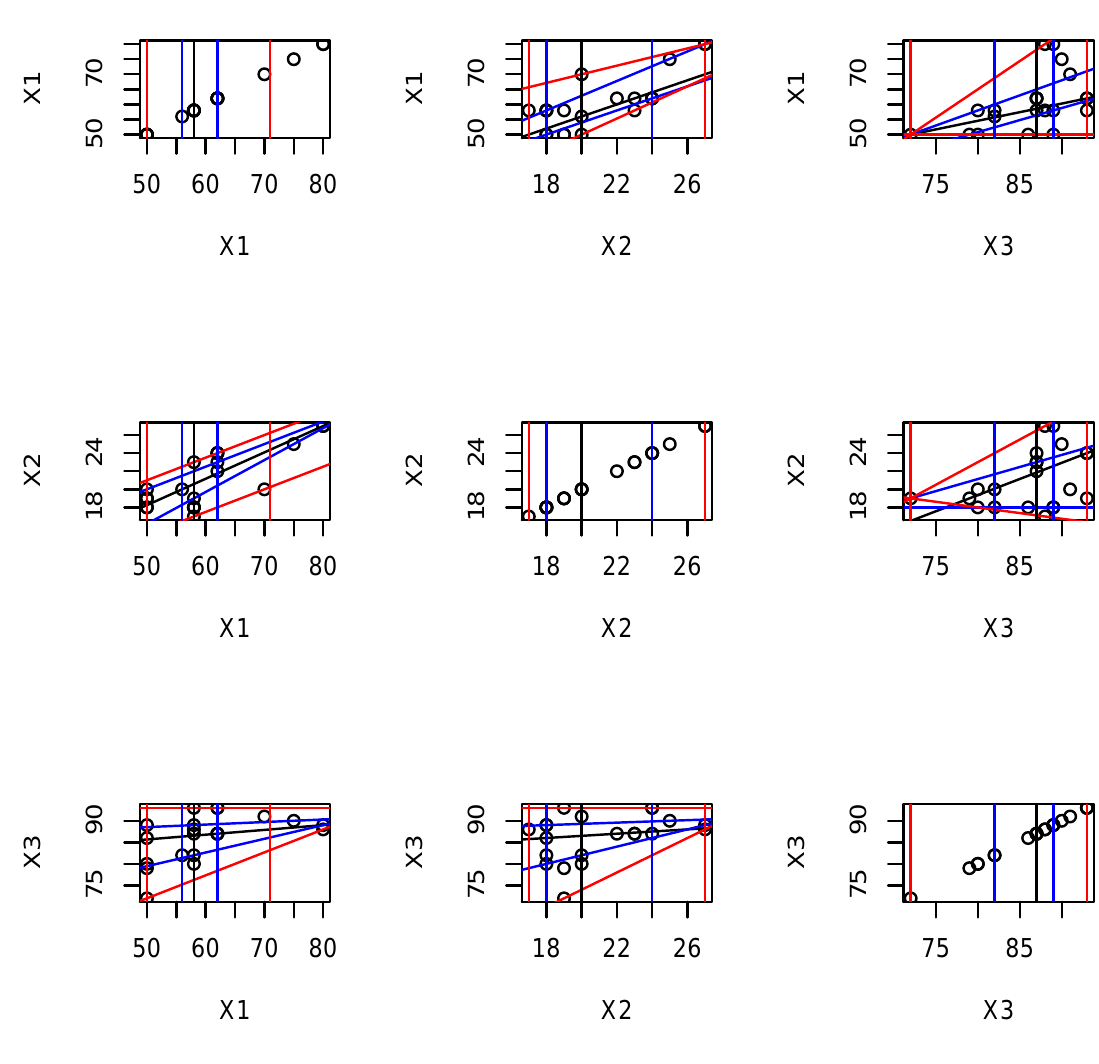
Figure 15: BBP obtained from linear quantile regression for a real data set with three variables. The vertical lines represent the univariate box